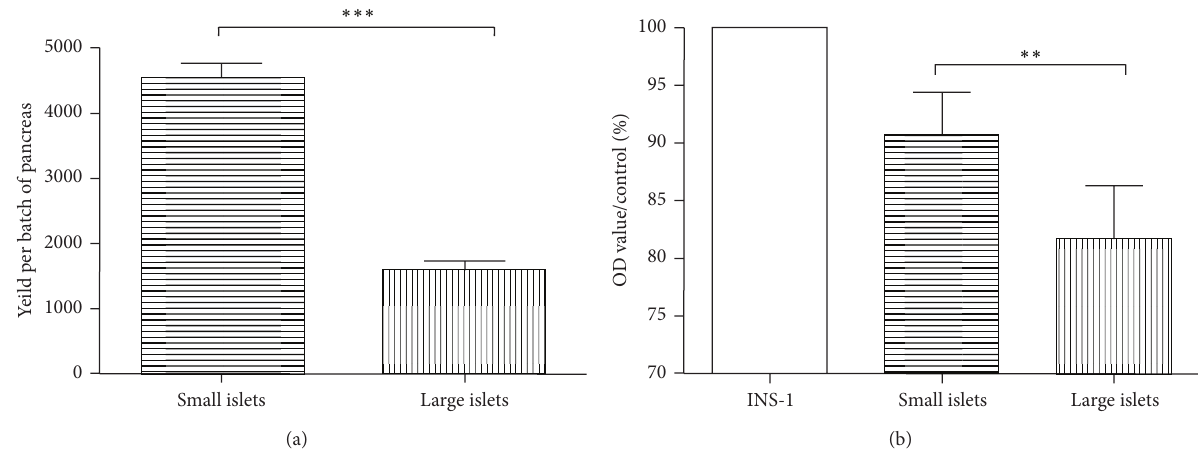
Figure 2: Distinct yield and islet cell viability between large and small islets freshly isolated. (a) Small islets are as twice to three times the amount of large ones isolated from each single batch of pancreas. (b) Islet cell viability analyzed by CKK-8 kit. Islet cells from freshly isolated small grafts are as much as 11% more viable than those from small ones ( 𝑃 = 0.0040